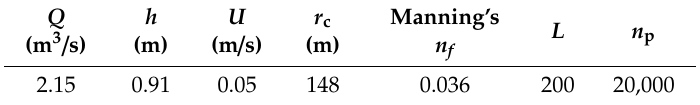
Figure 10. Outlines of the study site and the velocity distributions in the Hongcheon River. Table 4. Reach averaged hydraulic and simulation conditions in the Hongcheon River.